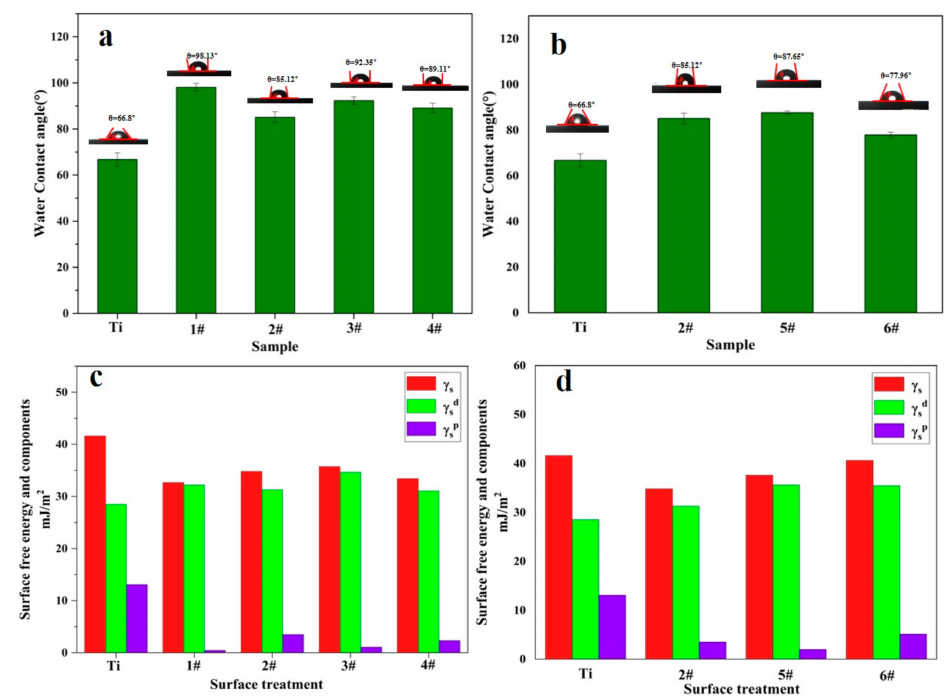
Figure 4. The contact angle and surface energy of various samples: ( a ) the contact angle of 1#–4#, ( b ) the contact angle of 2#, 5# and 6#, ( c ) free energy of 1#–4#, ( d ) free energy of 2#, 5# and 6#.